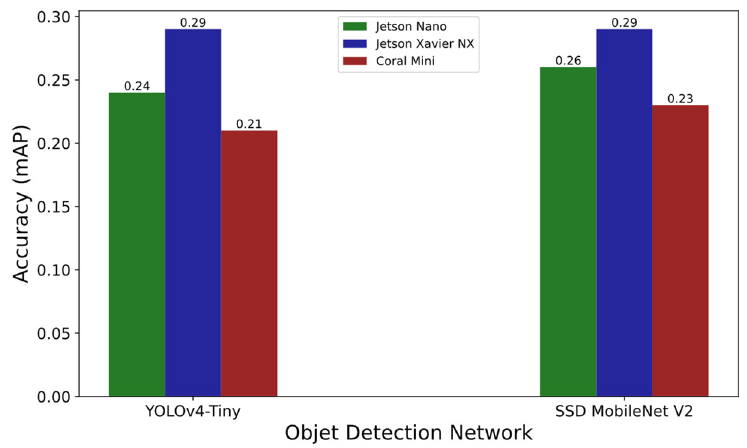
Figure 4. Detection Accuracy Measurement Results of the Devices.